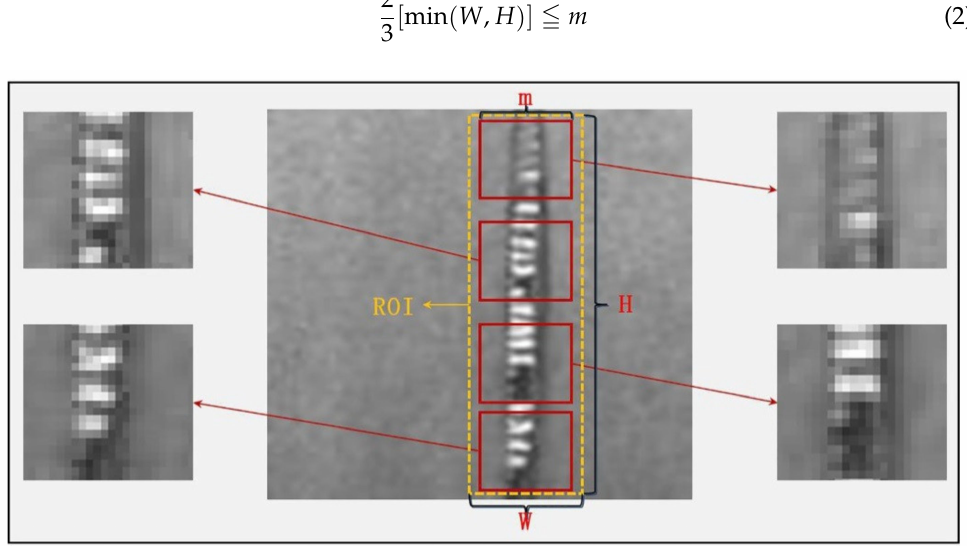
Figure 11. Image data augmentation algorithm based on ROI region random